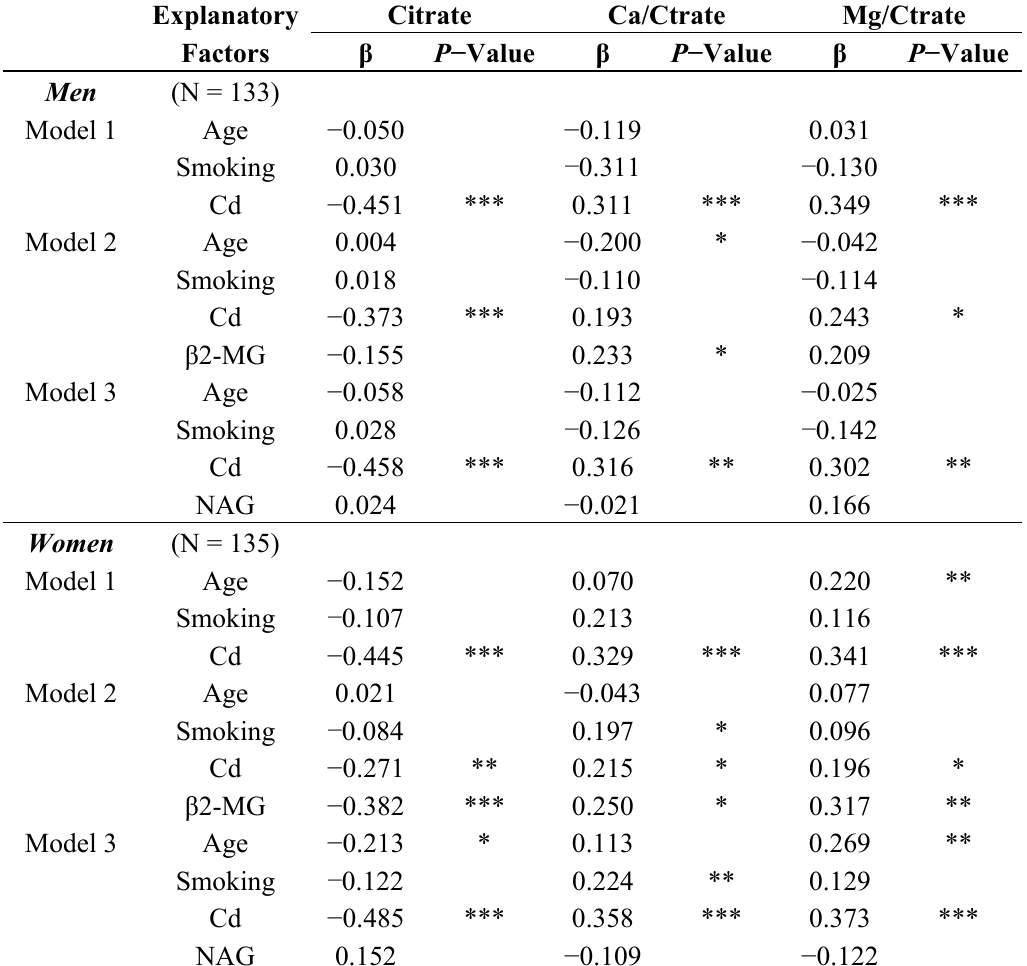
Table 5. Standardized regression coefficients ( β ) for urinary cadmium and renal markers in linear regression model for urinary citrate, calcium/citrate and